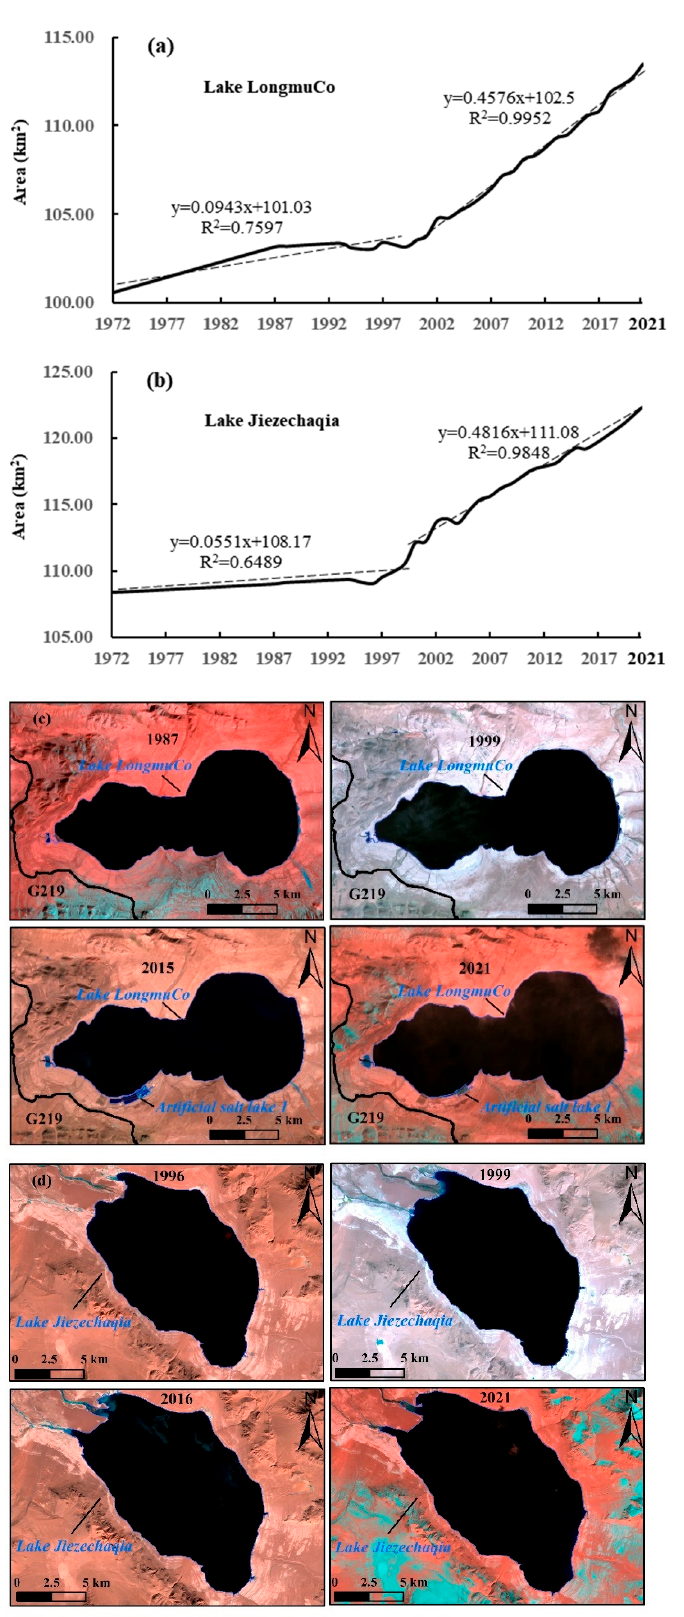
Figure 3. Area changes ( a , b ) and spatial distribution in different years ( c , d ) of Lake LongmuCo and Lake Jiezechaqia between 1972 and 2021.